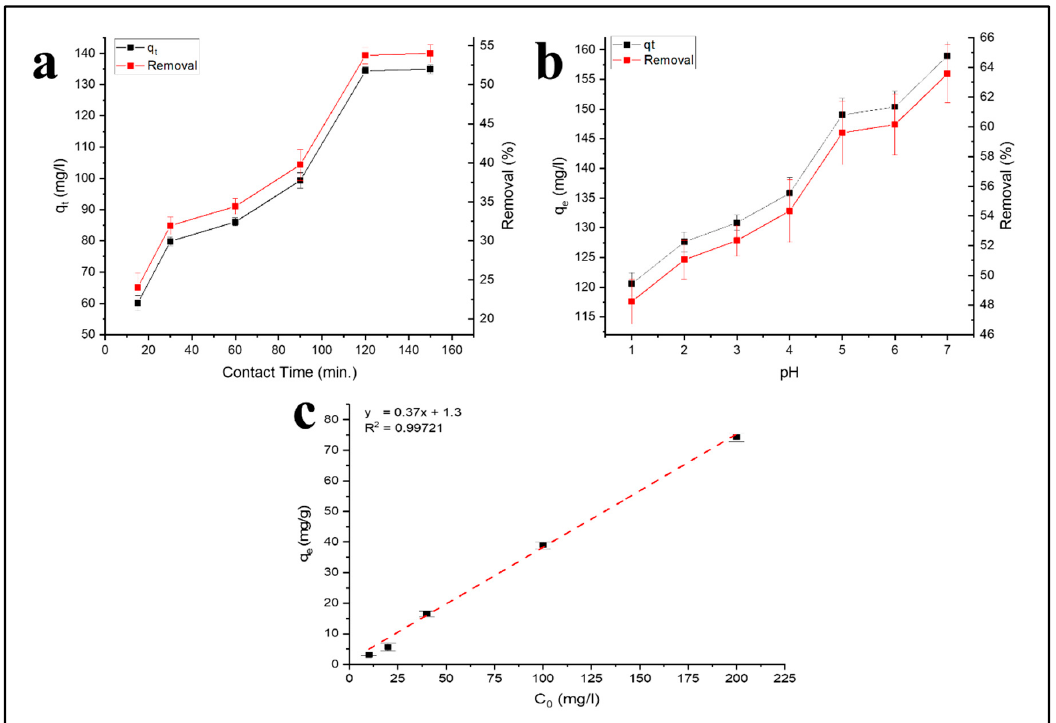
Figure 9. Effect of ( a ) contact time; ( b ) pH; and ( c ) initial concentration on Pb 2+ removal by the CA– Figure 9. E ff ect of ( a ) contact time; ( b ) pH; and ( c ) initial concentration on Pb 2 + removal by the CA–PU PU film adsorbent. film